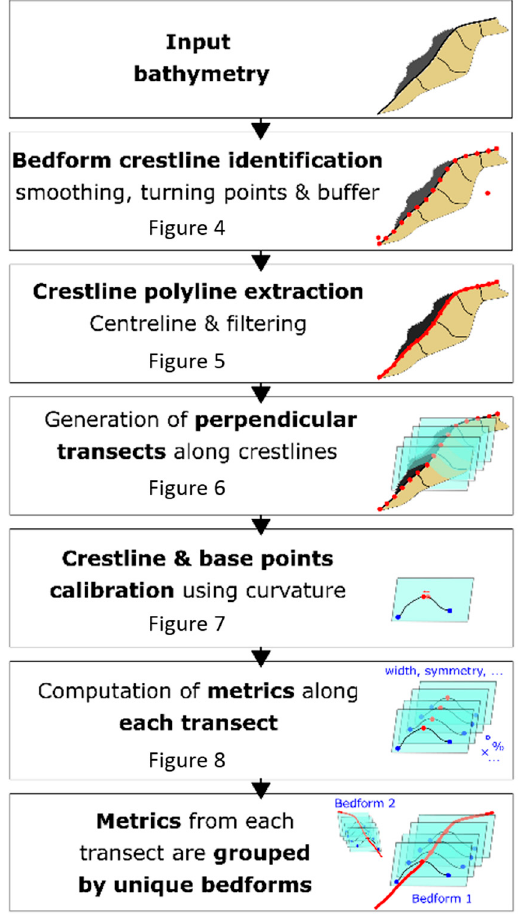
Figure 2. Automated bedforms extraction flowchart.